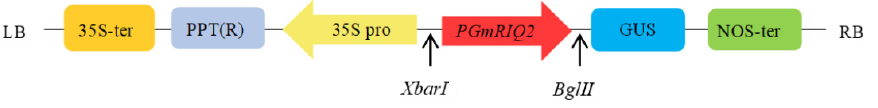
Figure 1. Schematic diagram of the pCAMBIA3301PGmRIQ2::GUS